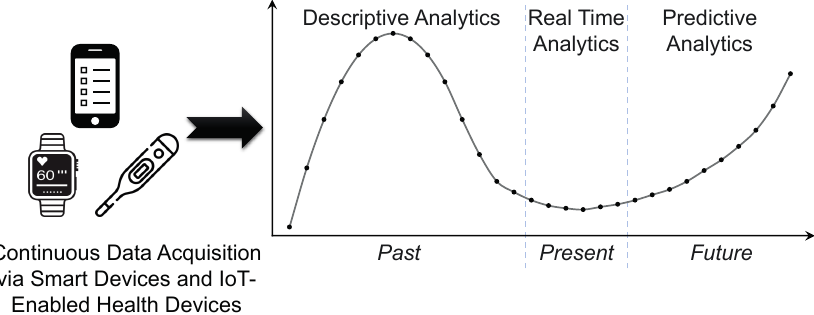
Figure 2. Three Types of Time-Series Analyses Applied in Health